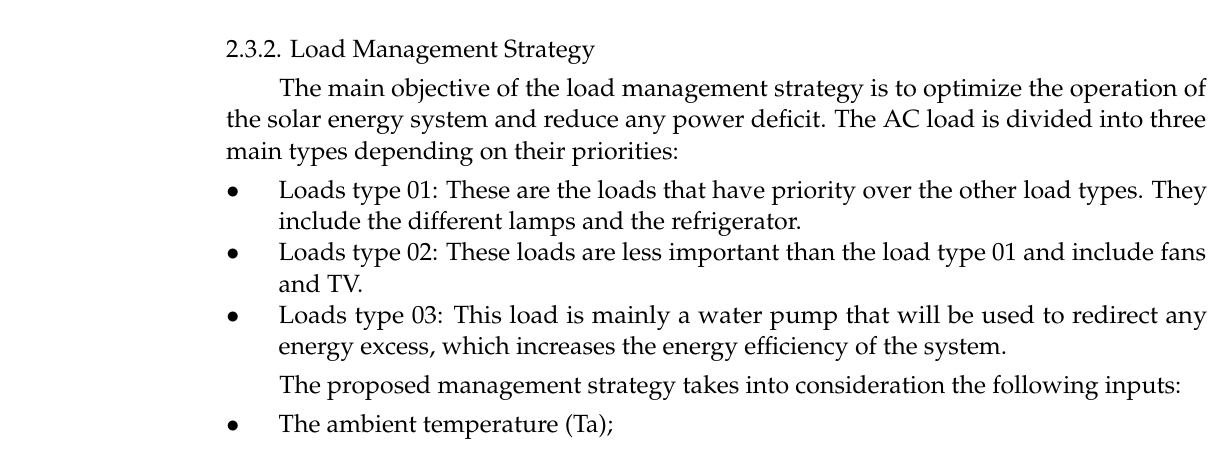
Figure 2. Operation strategy of the power system.